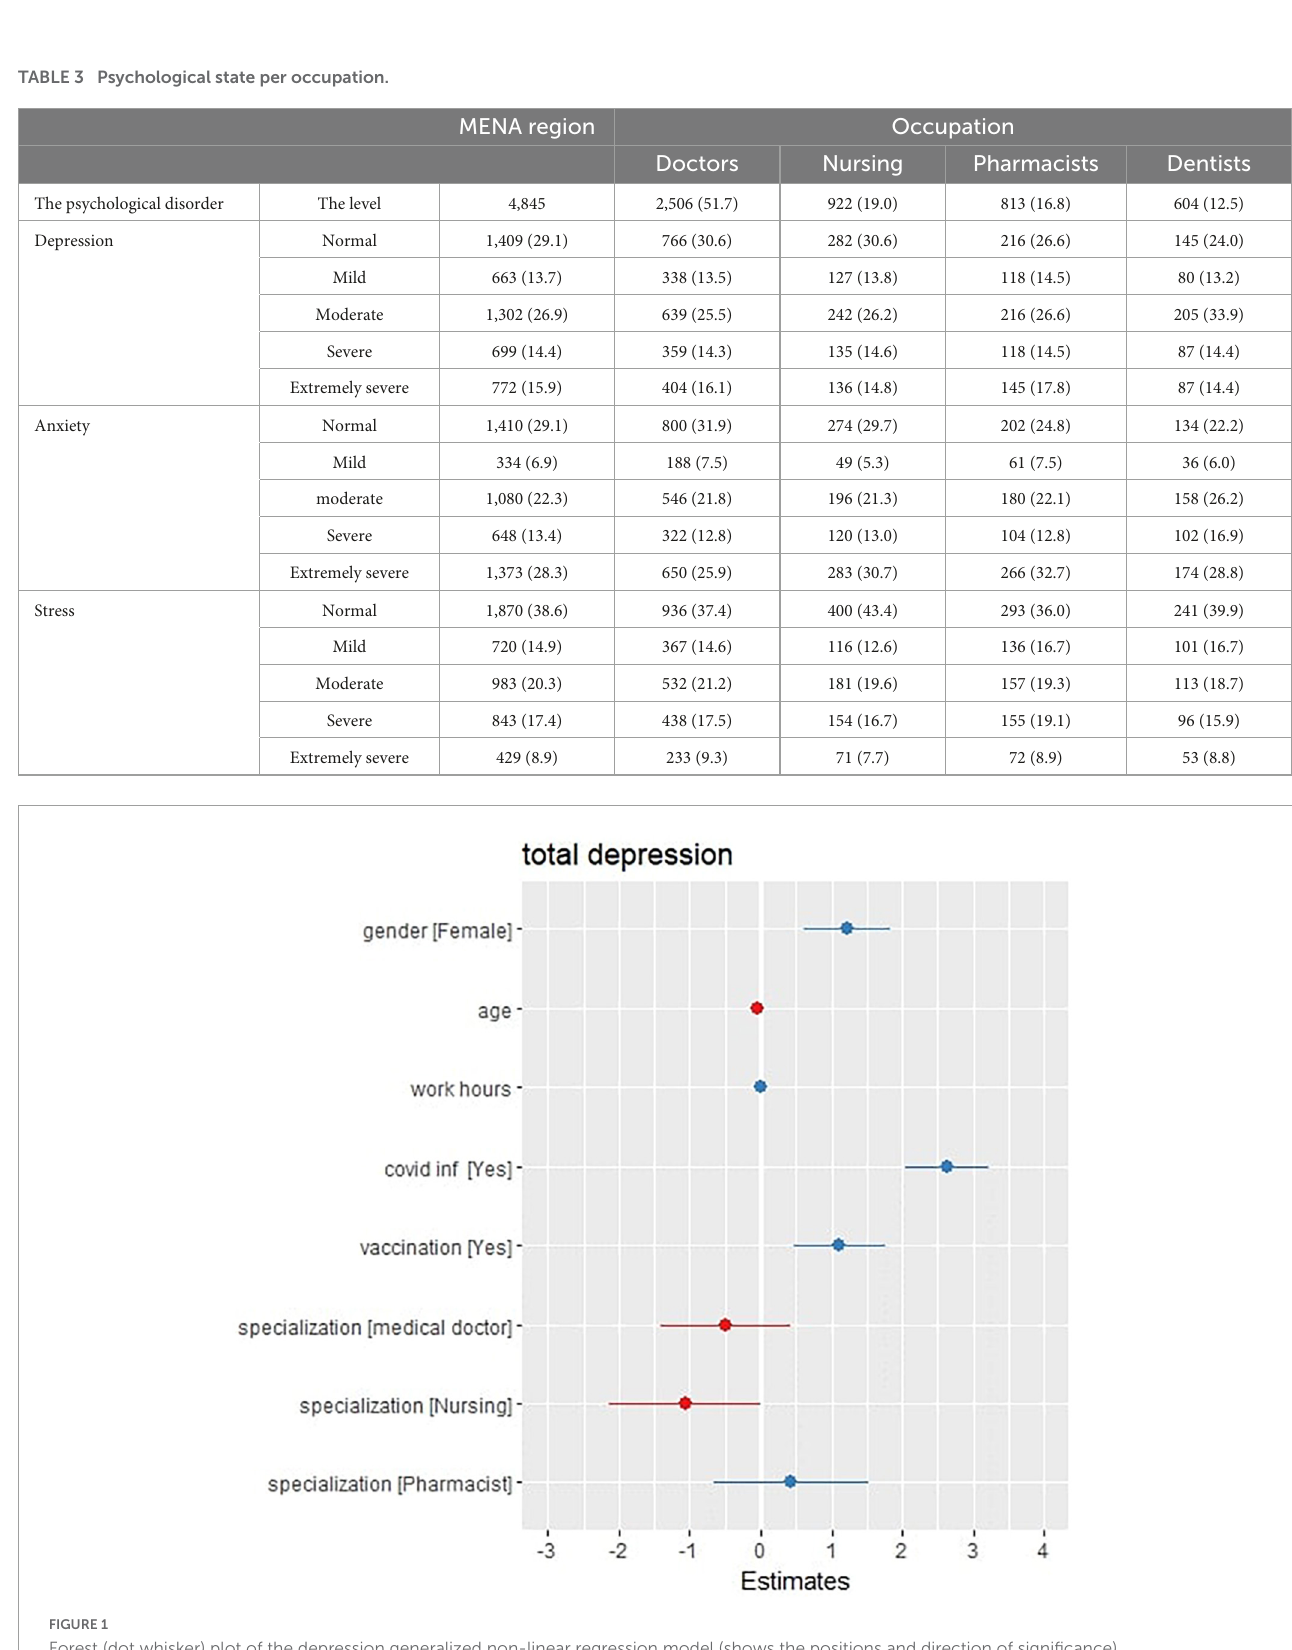
FIGURE1 Forest (dot whisker) plot of the depression generalized non-linear regression model (shows the positions and direction of